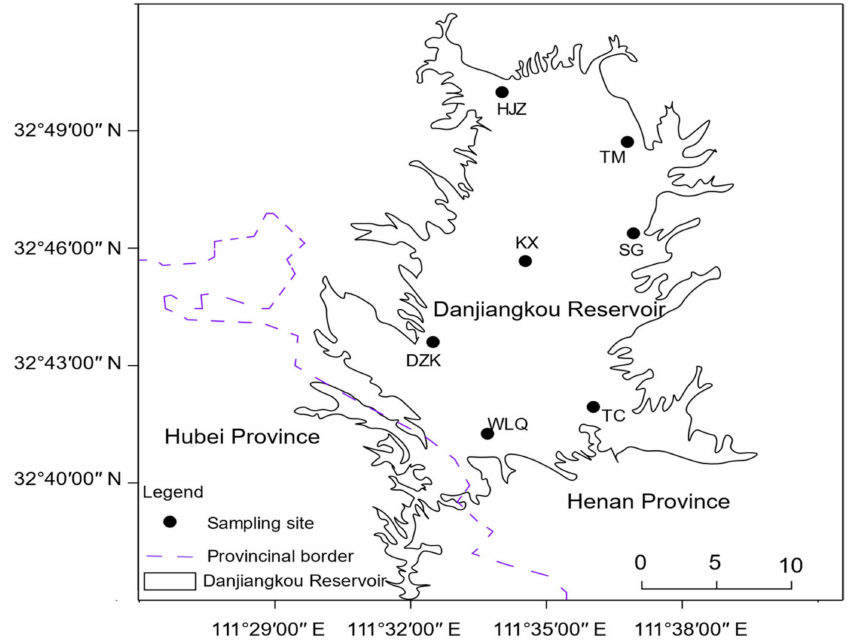
Figure 1. Setting of sampling points in the Henan section of the Danjiangkou Reservoir for physical and chemical index